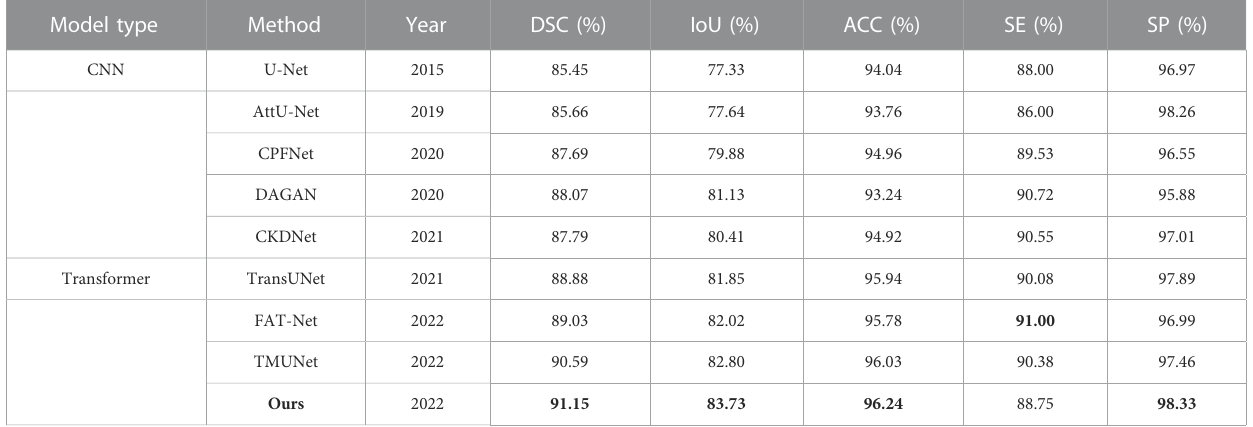
TABLE 4 Statistical comparison of the segmentation results on ISIC 2018. The best results are shown in bold. Model type